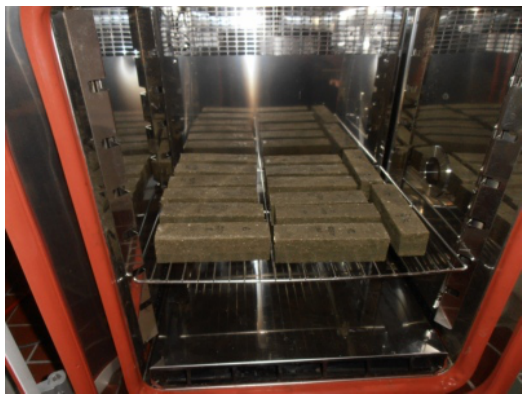
Figure 3. Production of the test bodies.